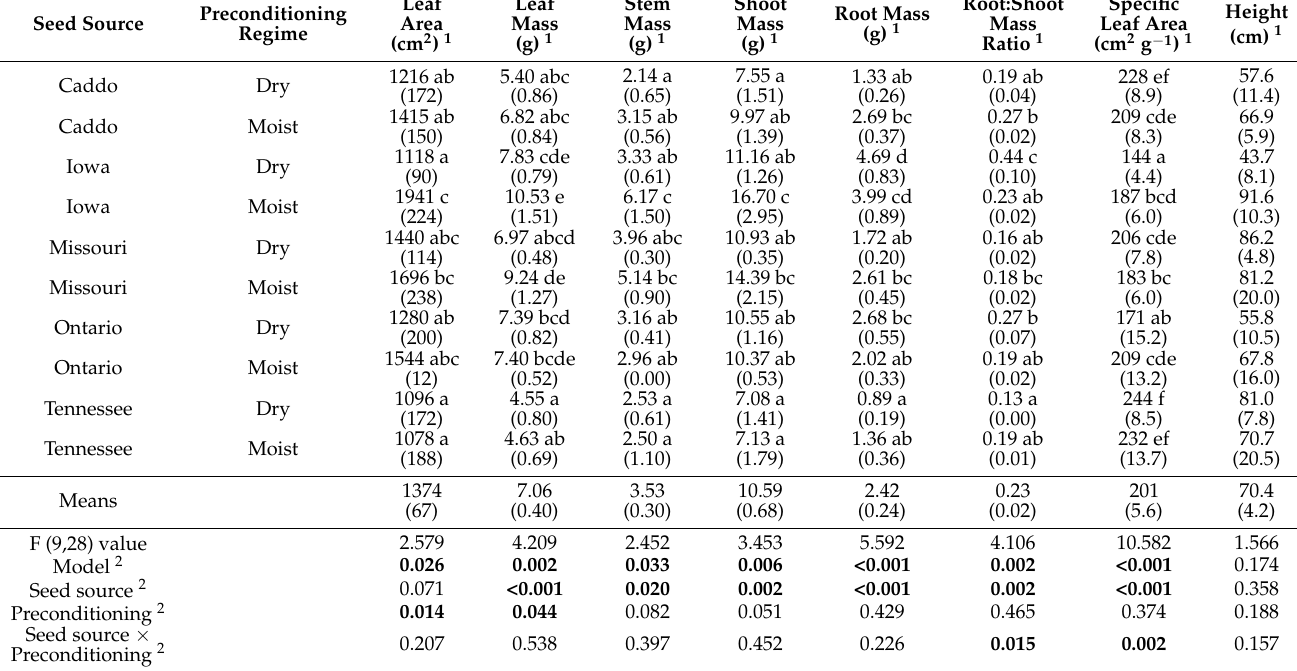
Table 3. Morphological characteristics after 7 weeks of preconditioning for 17-week-old Acer saccharum subsp. saccharum and Acer saccharum subsp. nigrum (Iowa) seedling by preconditioning through moist or dry cycles. ( n =